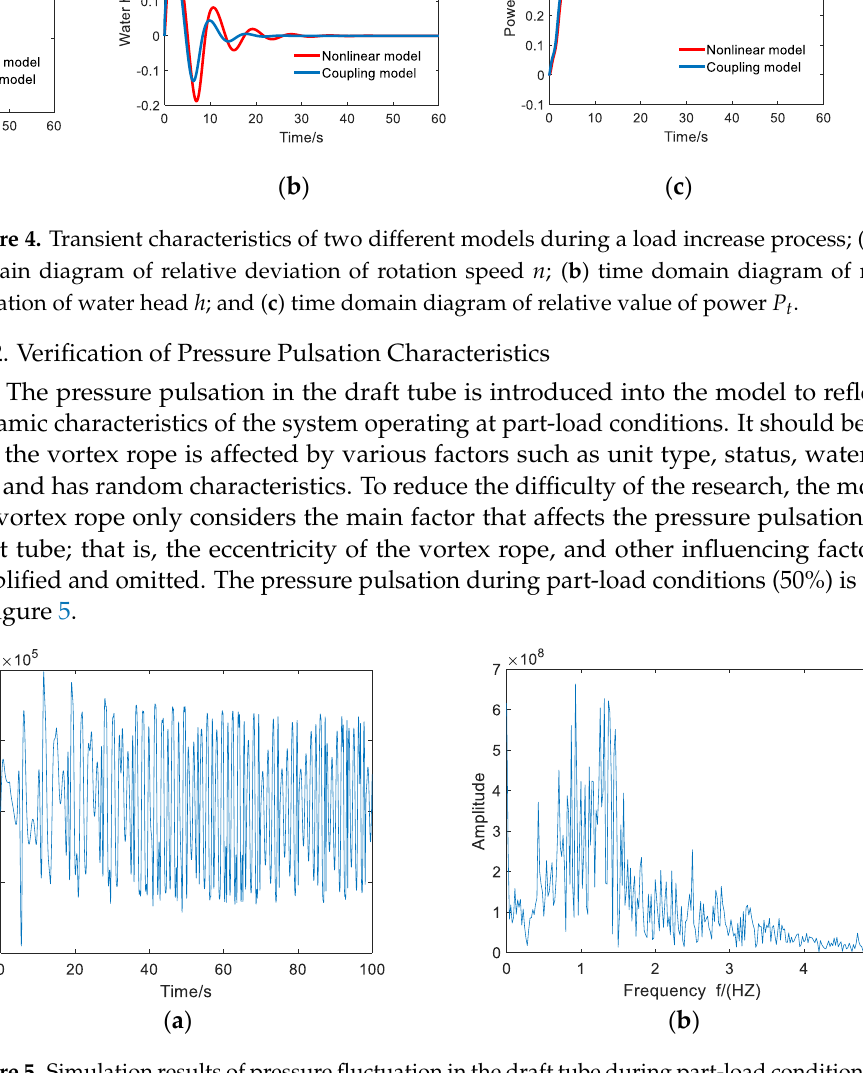
Figure 5. Simulation results of pressure fluctuation in the draft tube during part-load conditions (50%); ( a ) time domain diagram of pressure pulsation; ( b ) frequency-domain diagram of pressure pulsation.